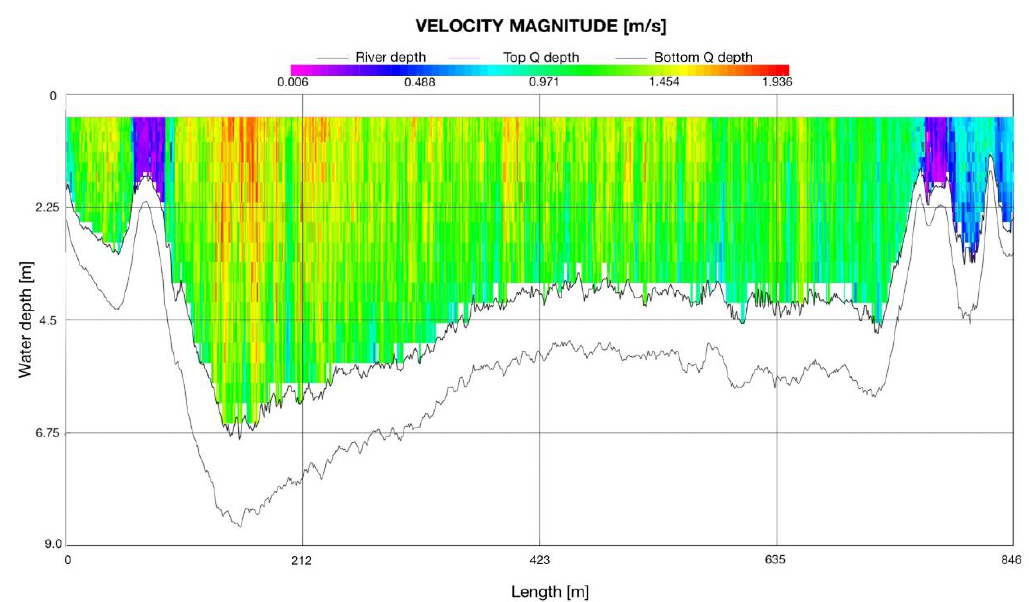
Figure 3. Acoustic Doppler Current Profiler (ADCP) observation conducted in the Niger River in Niamey (Soumana section) on 8 September 2020 with a flow depth of 698 cm (2850 m 3 /s).